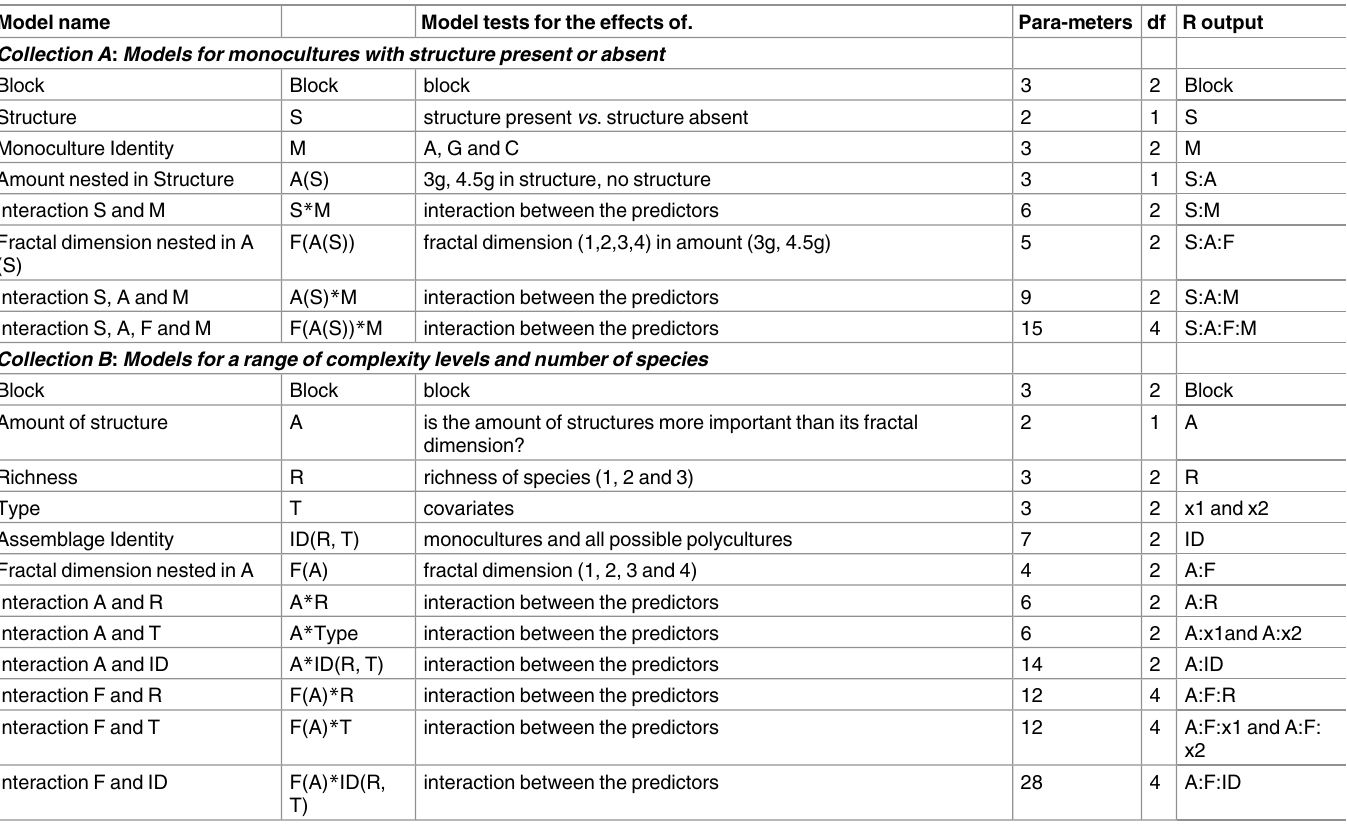
Table 1. Statistical models fitted in two collections of models.